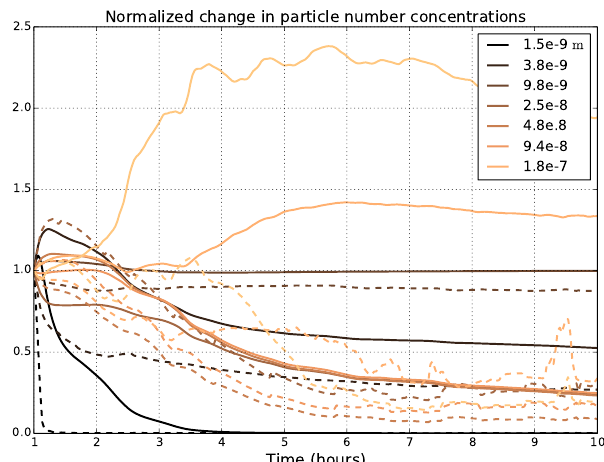
Figure 8. Normalised change in particle number concentration in each size bin. The concentrations are presented as a domain aver- age from the (i) below-cloud layer (solid lines) and (ii) in-cloud (dashed lines). In the latter case, the sum of the number of inter- stitial particles and activated CCN is presented for each bin. The two largest size bins are not shown because of very small absolute concentrations in this case. The legend gives the lower limit diam- eter of the presented size bins. Data are show from the end of the spin-up period. Number concentrations from this time are used as the normalising factor for each bin.